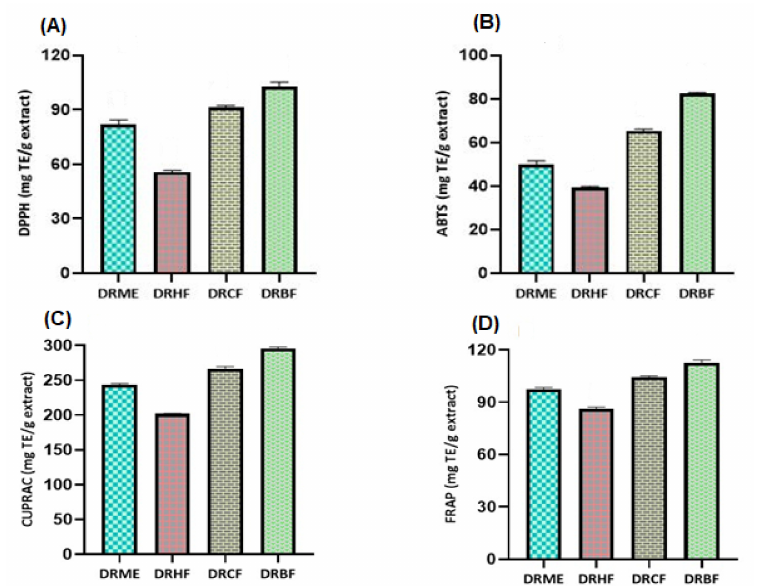
Figure 3. ( A ) 1,1-diphenyl-2-picrylhydrazyl (DPPH) and ( B ) 2,2-azinobis 3-ethylbenzothiazoline-6- sulfonic acid (ABTS); ( C ) cupric-reducing antioxidant capacity (CUPRAC) and ( D ) ferric-reducing antioxidant power (FRAP) of D. reflexa extract/fractions. DRME: methanolic extract; DRHF: n -hexane fraction; DRCF: chloroform fraction; and DRBF: n -butanol